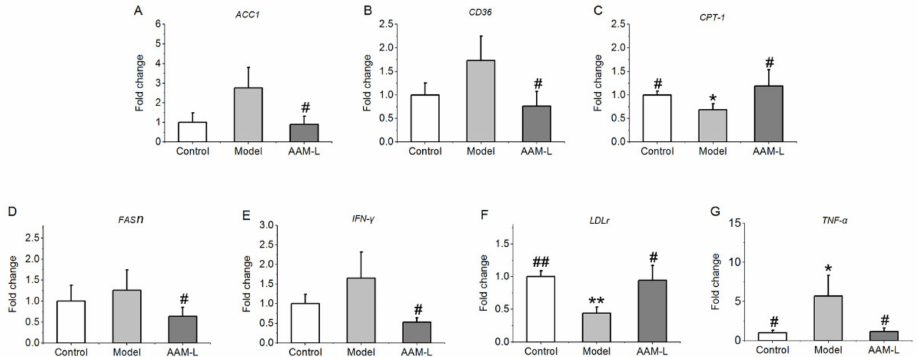
Figure 7. Effects of AAM administration on mRNA levels of hepatic genes in mice with ALD for consecutive 6 weeks. ( A ) ACC1 ; ( B ) CD36 ; ( C ) CPT-1 ; ( D ) FASn ; ( E ) IFN- γ ; ( F ) LDLr ; ( G ) TNF- α . ## p < 0.01 and # p < 0.05, versus the Model group; ** p < 0.01 and * p < 0.05, versus the Control